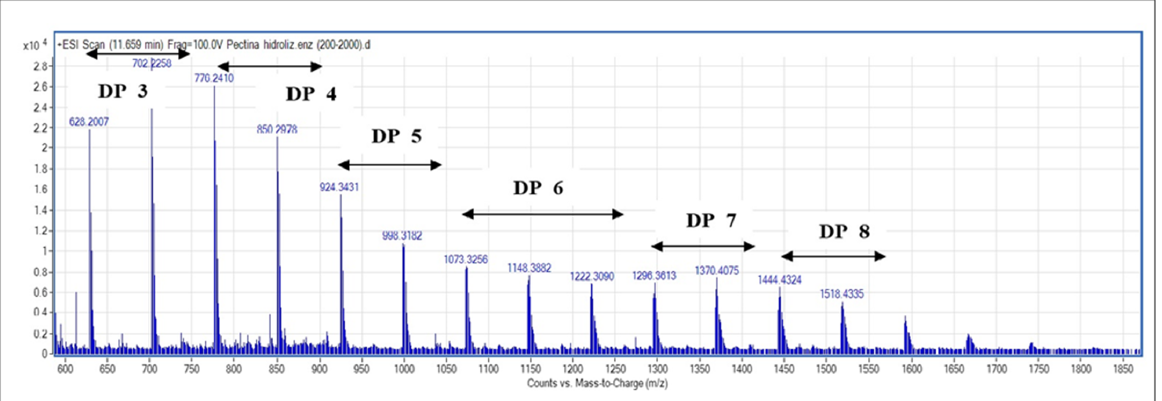
Figure 4. MS spectrum of the POS mixture in the range 600–1850 m / z (zoom scale) of the enzymatic hydrolysate of citrus peel pectin using Pectinex Ultra AFP. hydrolysate of citrus peel pectin using Pectinex Ultra